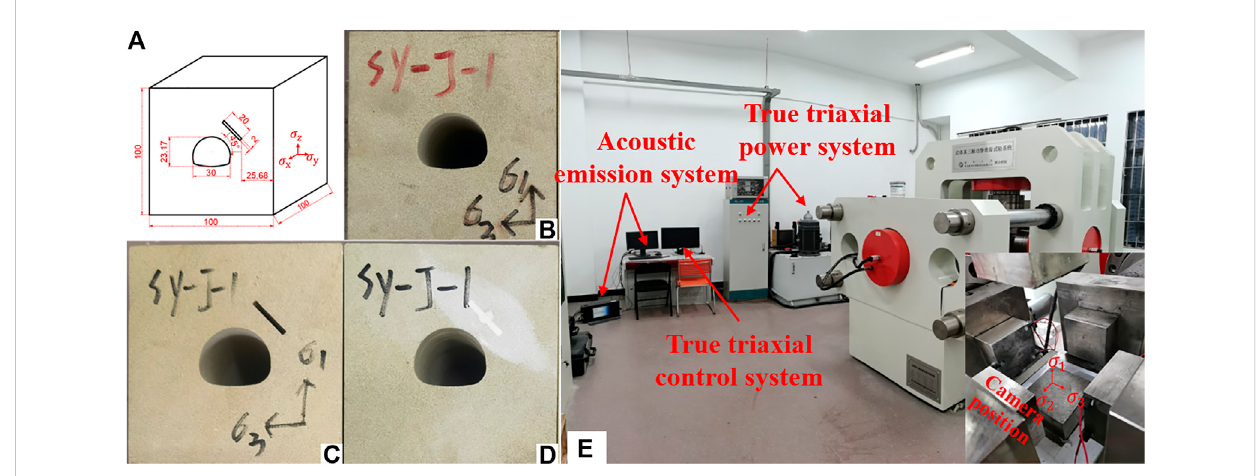
FIGURE 1 Test specimens: (A) distribution of tunnel and fl aws; (B) intact specimens; (C) open- fl aw specimens; (D) fi lled- fl aw specimens; (E) QKX-ZSZ- 4000 test equipment.